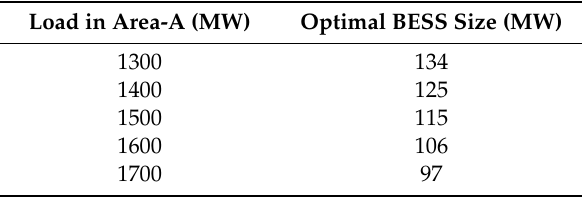
Table 6. Optimal BESS sizes under di ff erent load